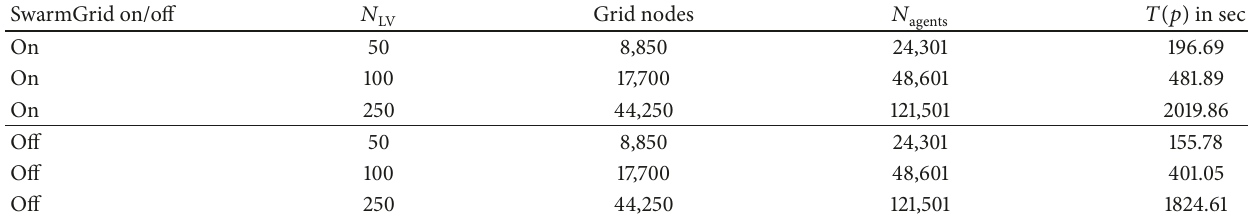
Table 4: Execution time results for large grid sizes generated with 96 processes on 4 computational nodes.